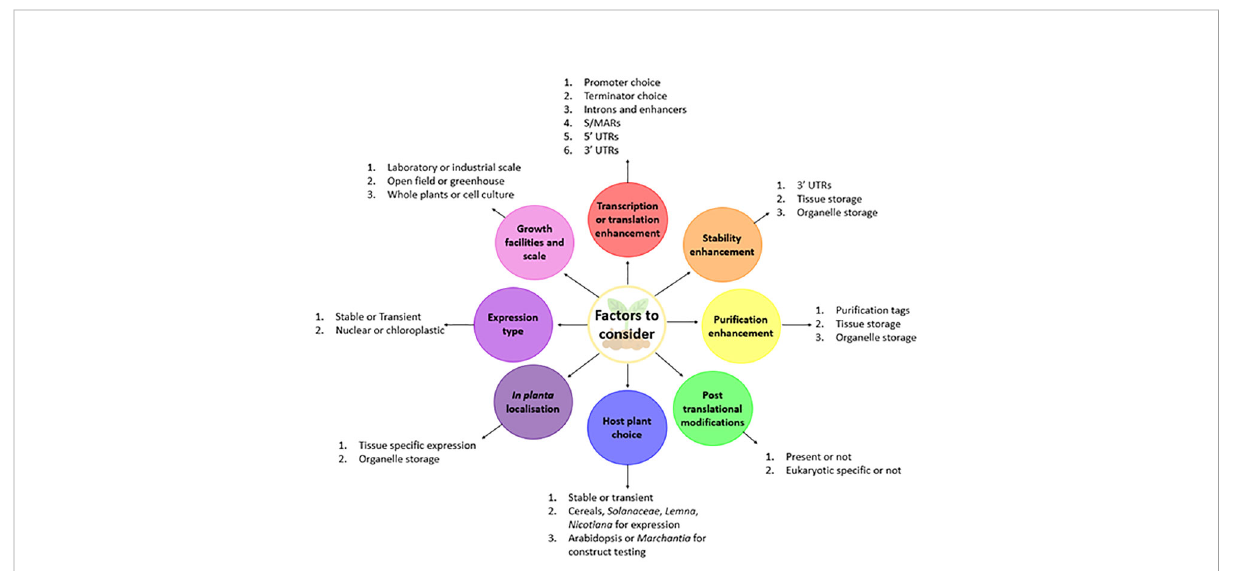
FIGURE 2 Summary of factors to consider when expressing recombinant proteins in